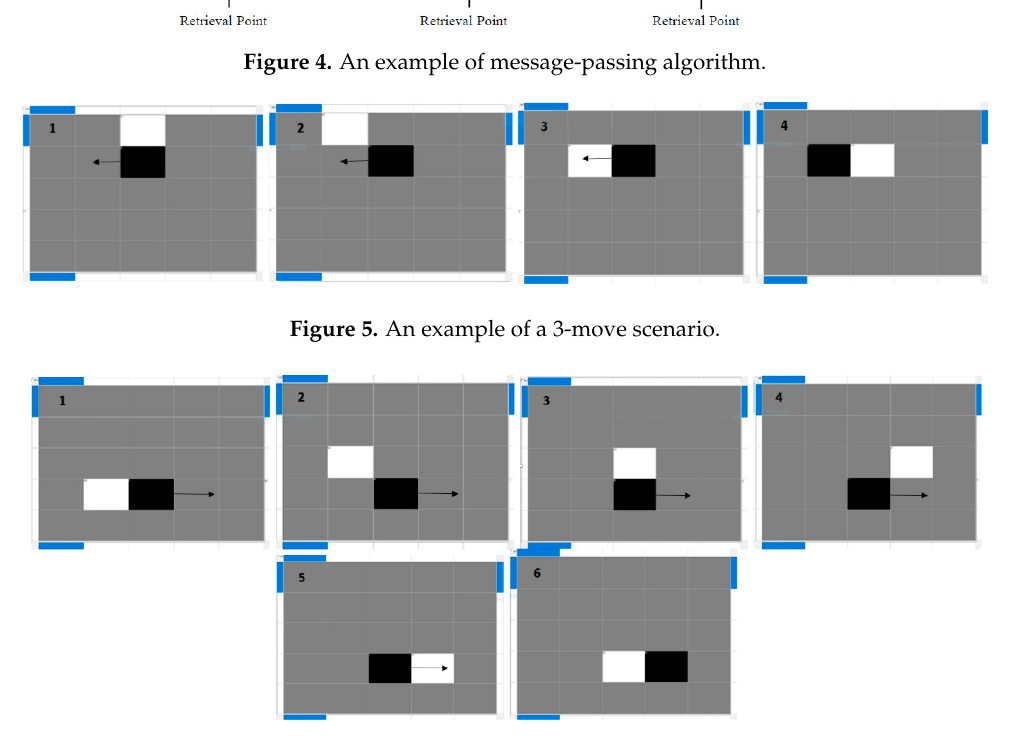
Figure 6. An example of a 5 ‐ move scenario.